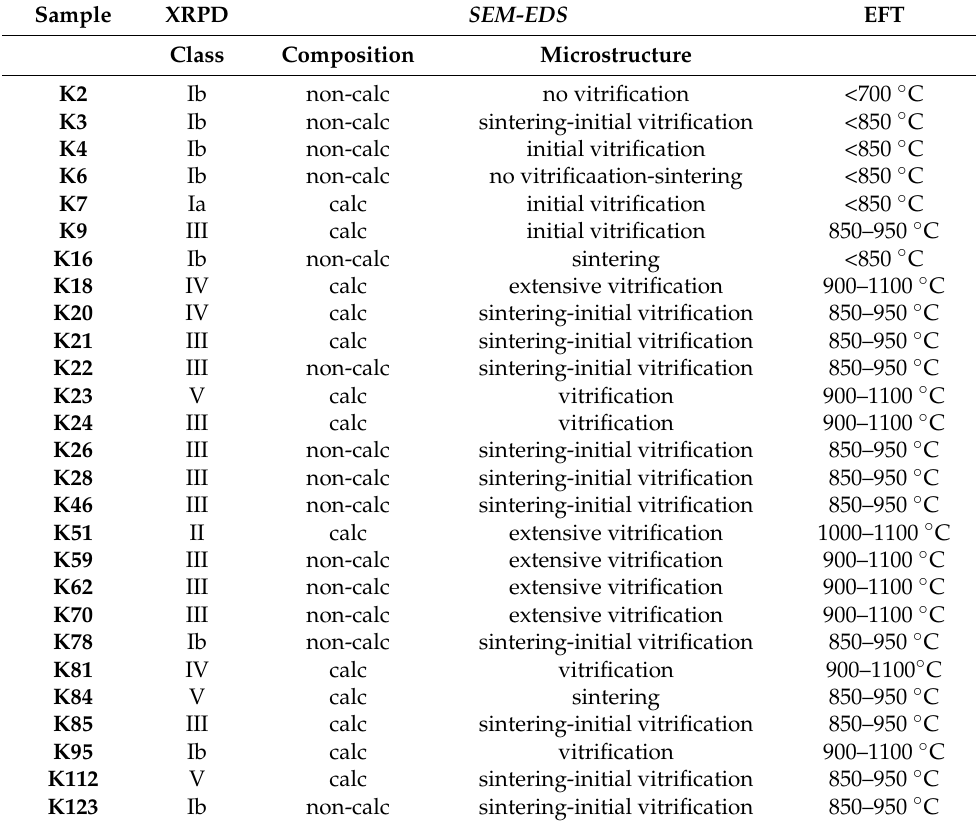
Table 3. Summary of XRPD and SEM-EDS results and determination of the equivalent firing temper- ature (EFT) according to the SEM. Non-calc (CaO < 6%) and calc (CaO >